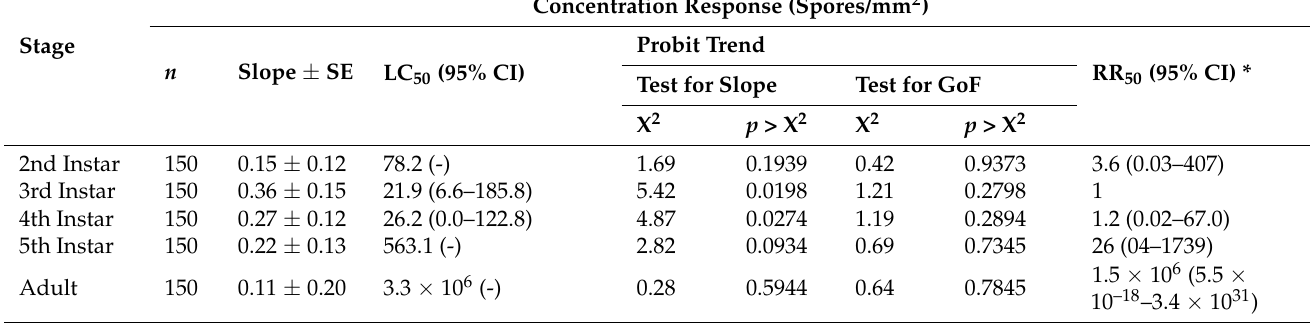
Table 5. Lethal Sporulation-response (LS 50 ) of different stages of Nezara viridula treated by direct spray with Beauveria bassiana , Mississippi Delta native strain